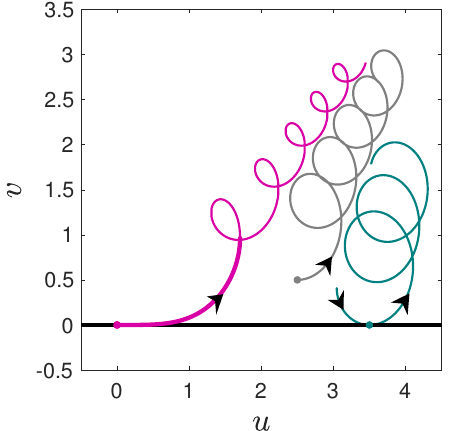
Figure 1. Three representative trajectories. Teal curve is the trajectory launched tangent to the u -axis away from the nucleus. Grey curve represents a trajectory launched off the u -axis away from the nucleus. Magenta trajectory is the trajectory launched away from the nucleus along the u -axis. The thick magenta curve represents the portion of the trajectory used to define the surface of section (SOS). ( B = 2, 1.1, where B and E are the magnetic field strength and the energy in scaled E = −